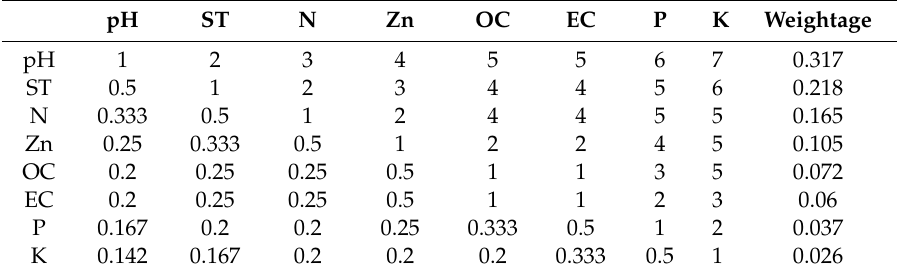
Table 6. Pair wise comparison matrix and eigenvector of criteria in AHP for jute crop ( n = 8). pH ST N Zn OC EC P